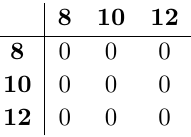
Figure H.1. Evolution along the shortest paths of a COVID-19 topic on the first day to a COVID-19 health care focused topic on the last day illustrated as top word clouds. The paths are computed on a 8 - (top) and a 12 - (bottom) nearest neighbor graph. The middle two word clouds are illustrations of two of the topics on the paths at the same time points as those in Figure 2. Note that the intermediate topics in both cases represent natural transformations from the beginning to the end topics, confirming that the shortest path is not sensitive to small perturbations of k around 10 .